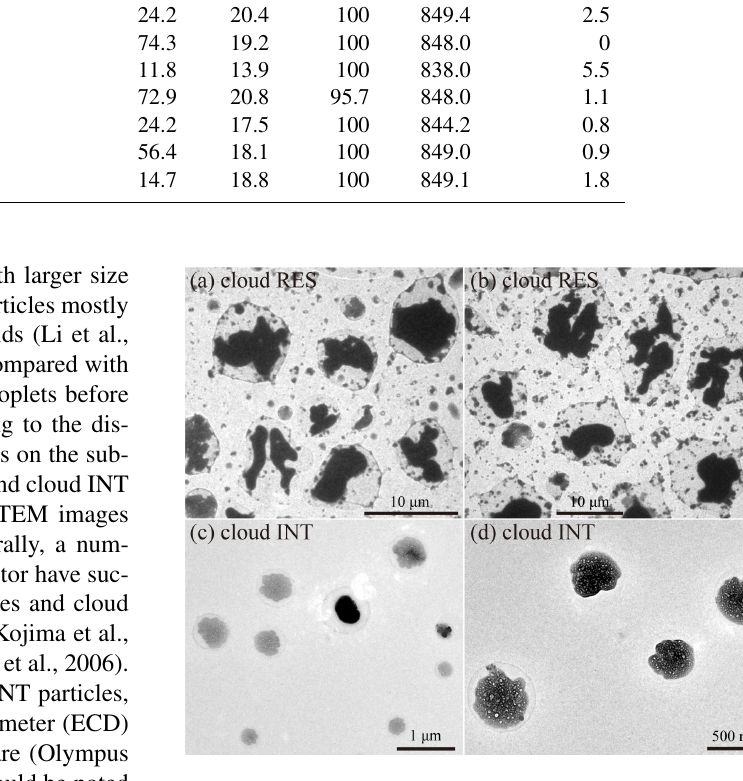
Figure 2. Low-magnification TEM images of cloud RES (a–b) and cloud INT (c–d) particles collected on Mt.